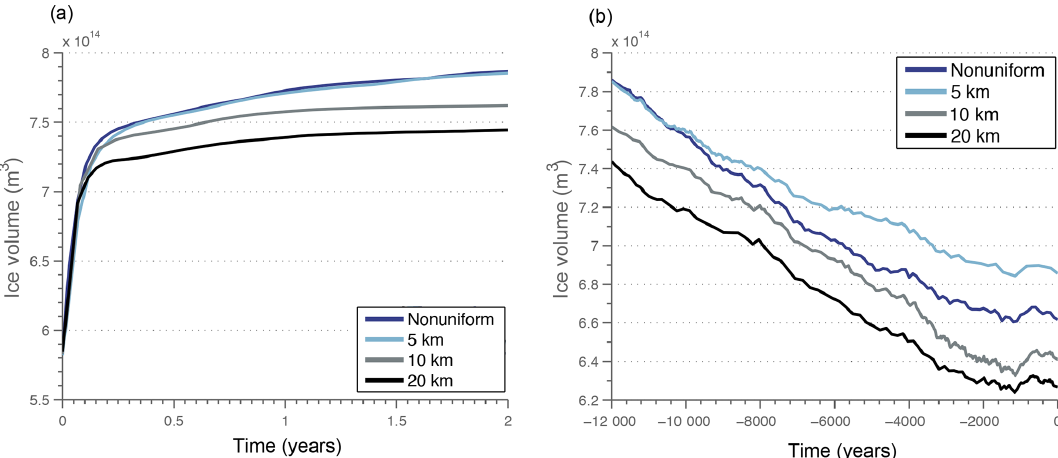
Figure 4. (a) Ice volume evolution for the 12ka constant climate relaxation. (b) Transient ice volume evolution for the simulations from 12ka to present